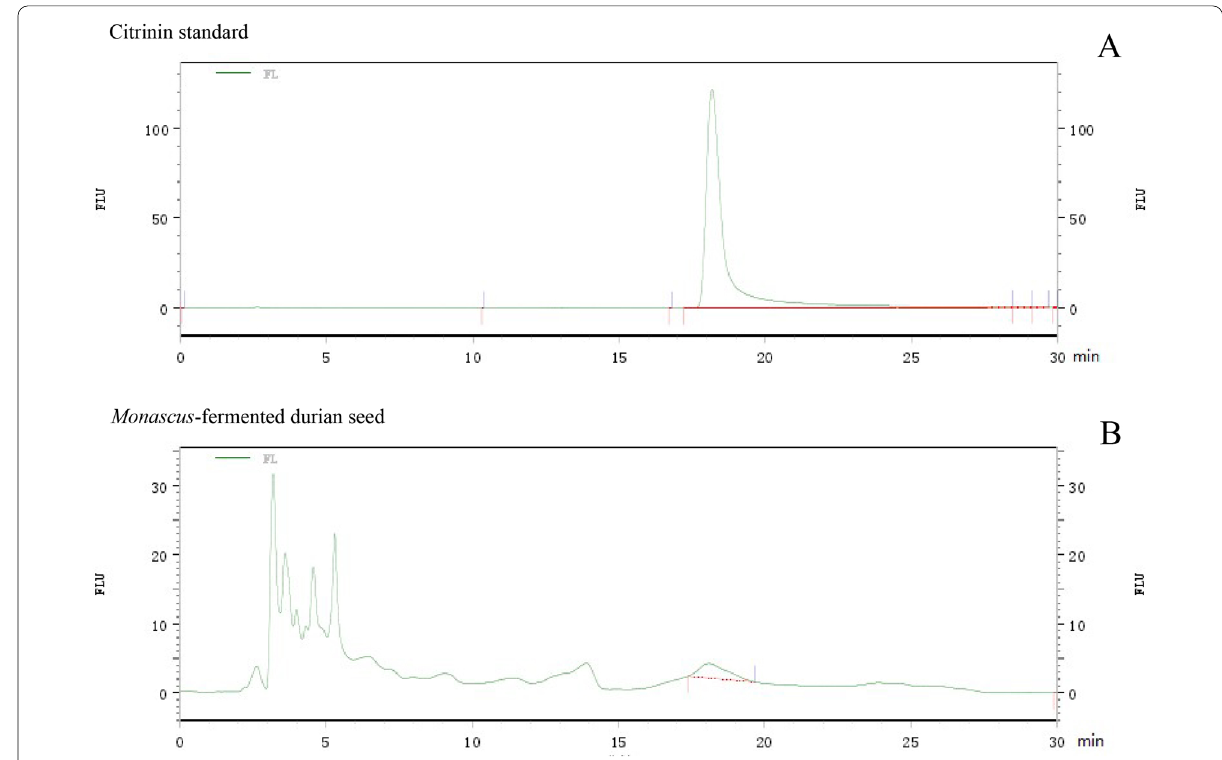
Fig. 5 HPLC analysis of citrinin standard ( A ) and citrinin content in Monascus -fermented durian seed ( B